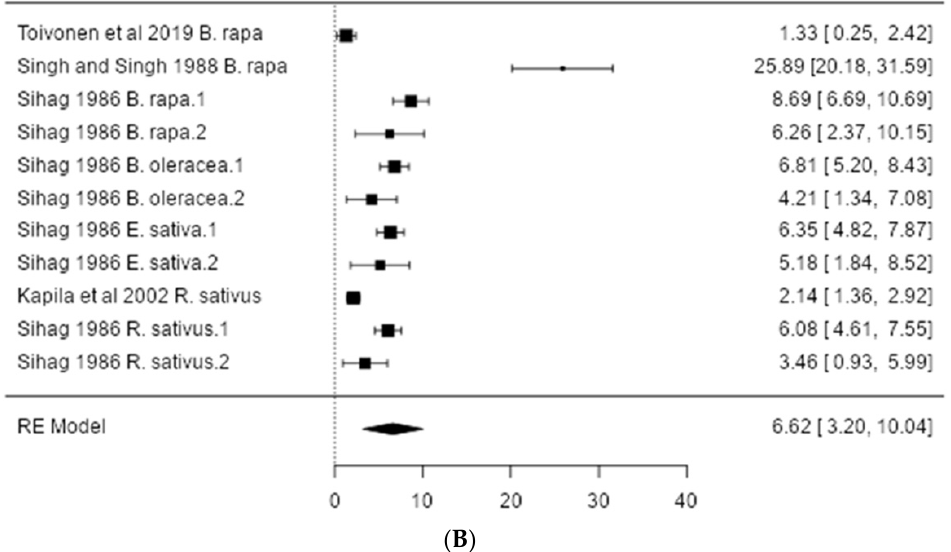
Figure 3. Forest plot of meta-analysis for the effect of insect pollination on seed yield in self-compatible ( A ) and self-incompatible Brassicaceae crops ( B ). Table 3. Heterogeneity statistics and publication bias based on Begg and Mazumdar rank correlation for the meta-analyses conducted to test the effect of insect pollination on yield parameters in self- compatible (SC) and self-incompatible (SI) Brassicaceae. The yield parameters included in the meta-analysis were seed yield measured as seed weight/(plant, area, or open flower) (Y); weight of seeds (WS); silique set (SQS); number of siliquae/(plant or area) (NSQ); and number of seeds/(silique or open flower)